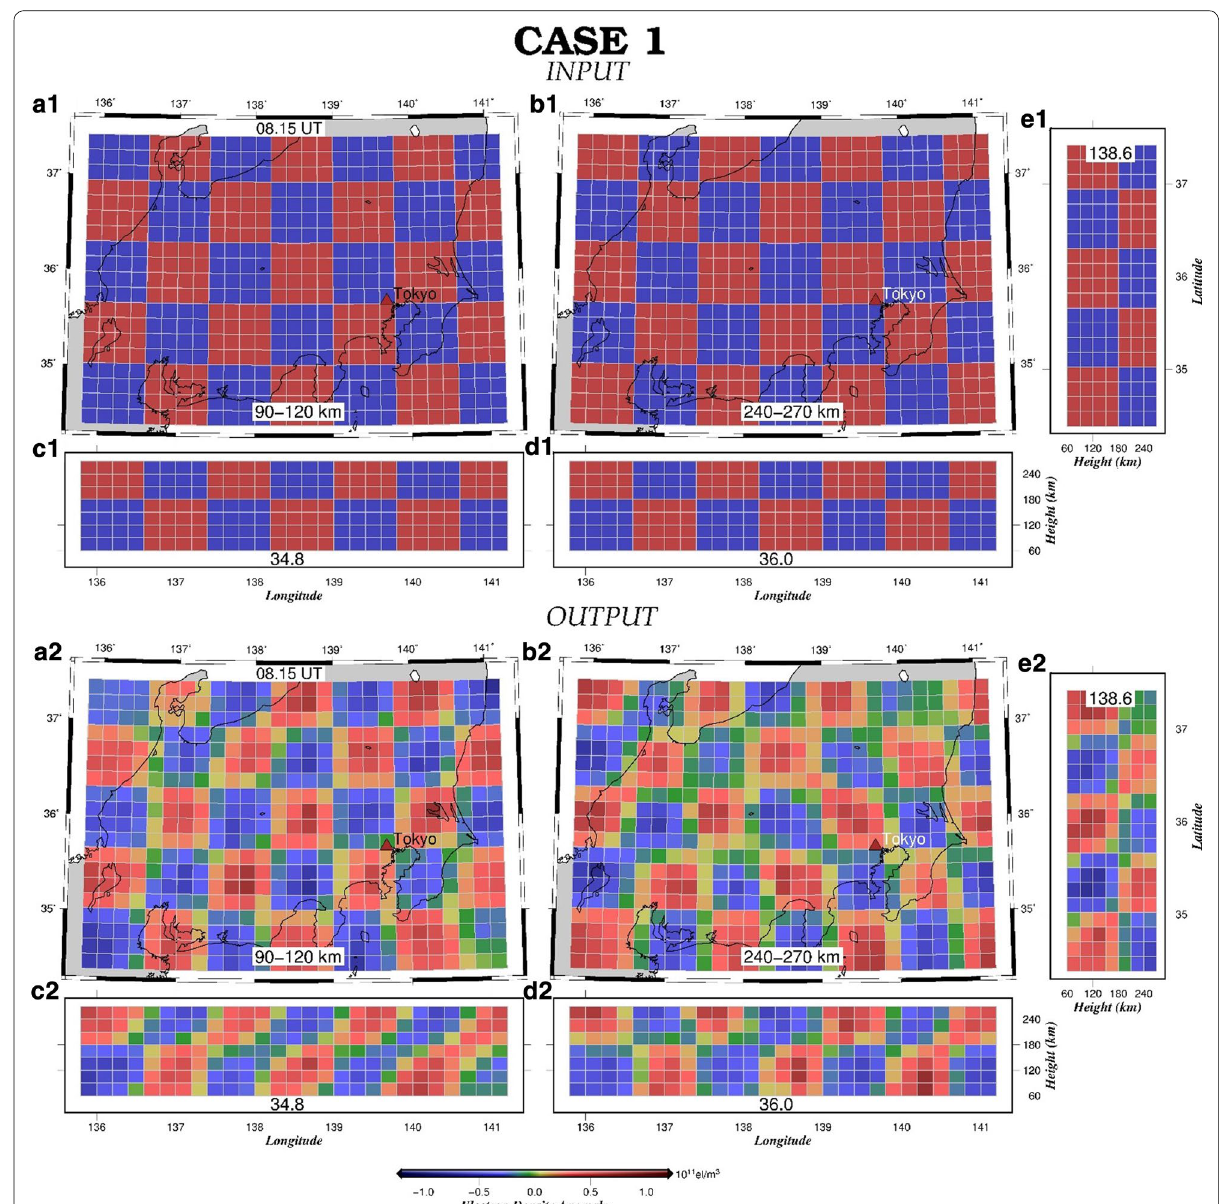
Fig. 2 Checkerboard resolution test with pattern shown in the input (upper panels) and output (lower panels) of the 3D tomography. Satellites and stations of Case 1 are